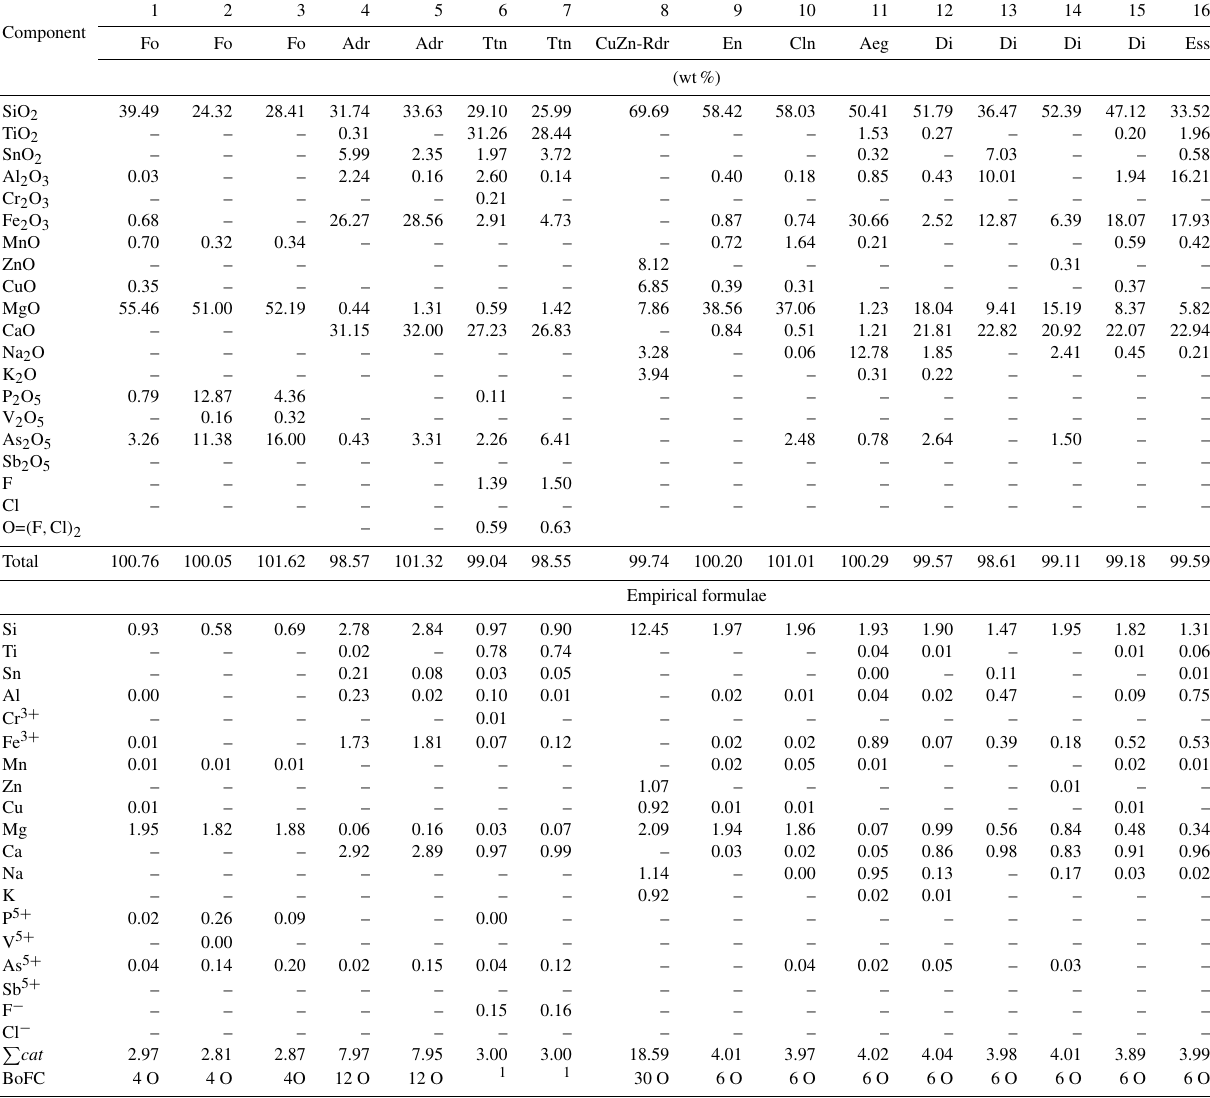
Table 3. Typical chemical composition of forsterite (Fo), andradite (Adr), titanite (Ttn), the Cu,Zn-rich analogue of roedderite (CuZn- Rdr), enstatite (En), clinoenstatite (Cln), aegirine (Aeg), diopside (Di), esseneite (Ess), Cu,Mg-pyroxene (Cu-Px), potassic-fluoro-magnesio- arfvedsonite (Arf), potassic-fluoro-richterite (Rch), litidionite (Ltd), fluorophlogopite (FPhlg), yanzhuminite (Ynzh), fluoreastonite (FEst) and the Sn analogue of dalyite (Sn-Dlt) from the Arsenatnaya fumarole. The samples containing significant impurities of ore components are